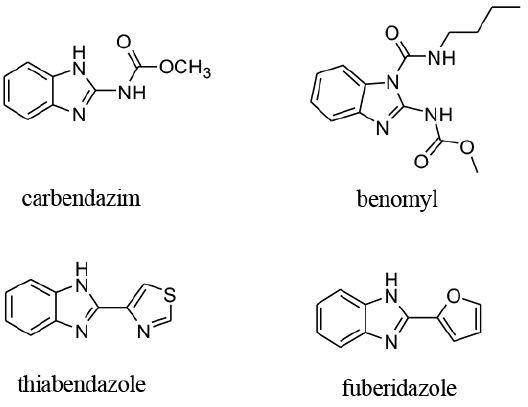
Figure 1. The commercialization of pesticide.